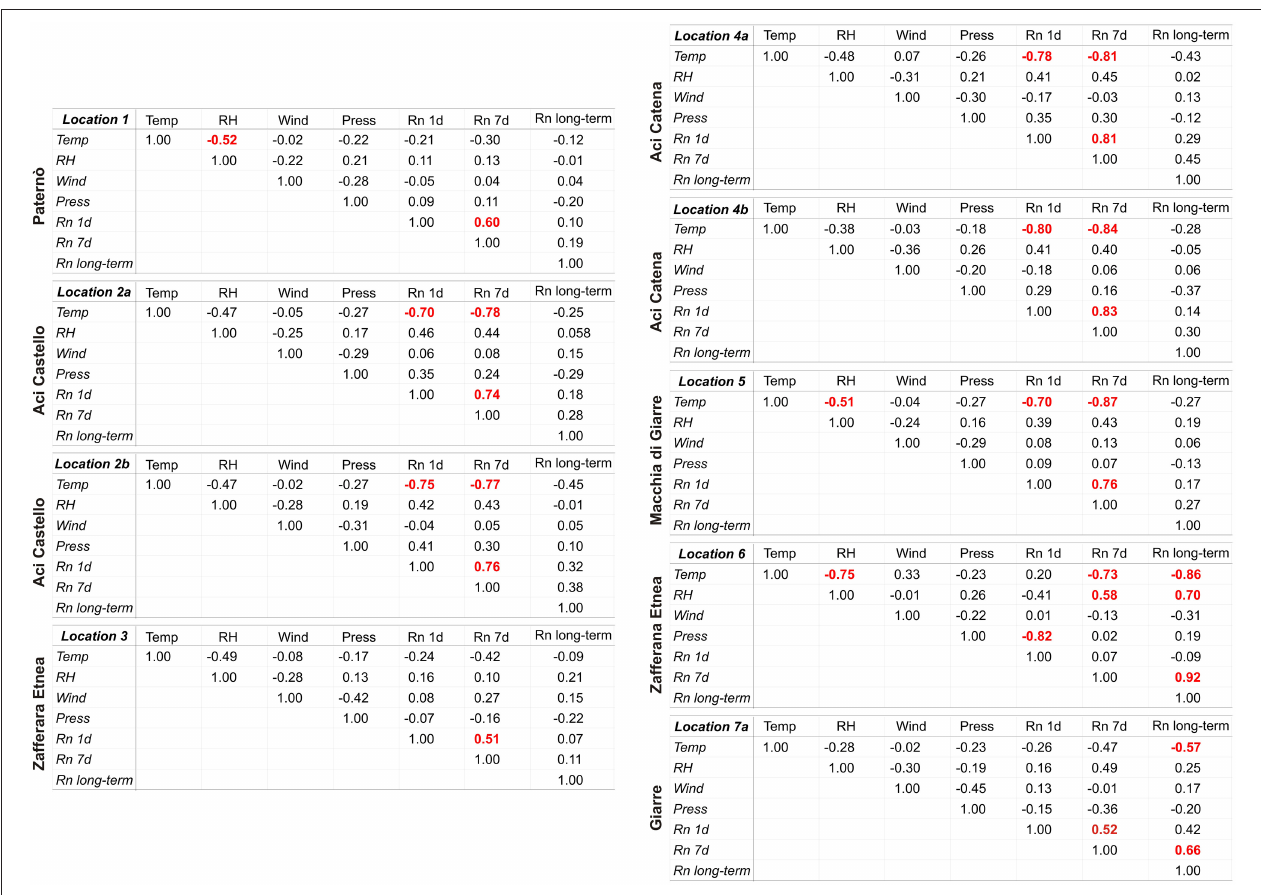
FIGURE 10 | Correlation matrixes between average daily, weekly and long-term radon activity concentrations (indicated, respectively, with Rn 1d, Rn 7d, and Rn long-term) and the corresponding average daily values of air temperature (Temp), air relative humidity (RH), wind speed (Wind), and barometric pressure (Press) at the locations with the longest periods of indoor radon monitoring. Values of the Pearson correlation coefficient higher than ± 0.50 are considered statistically significant and therefore were highlighted in